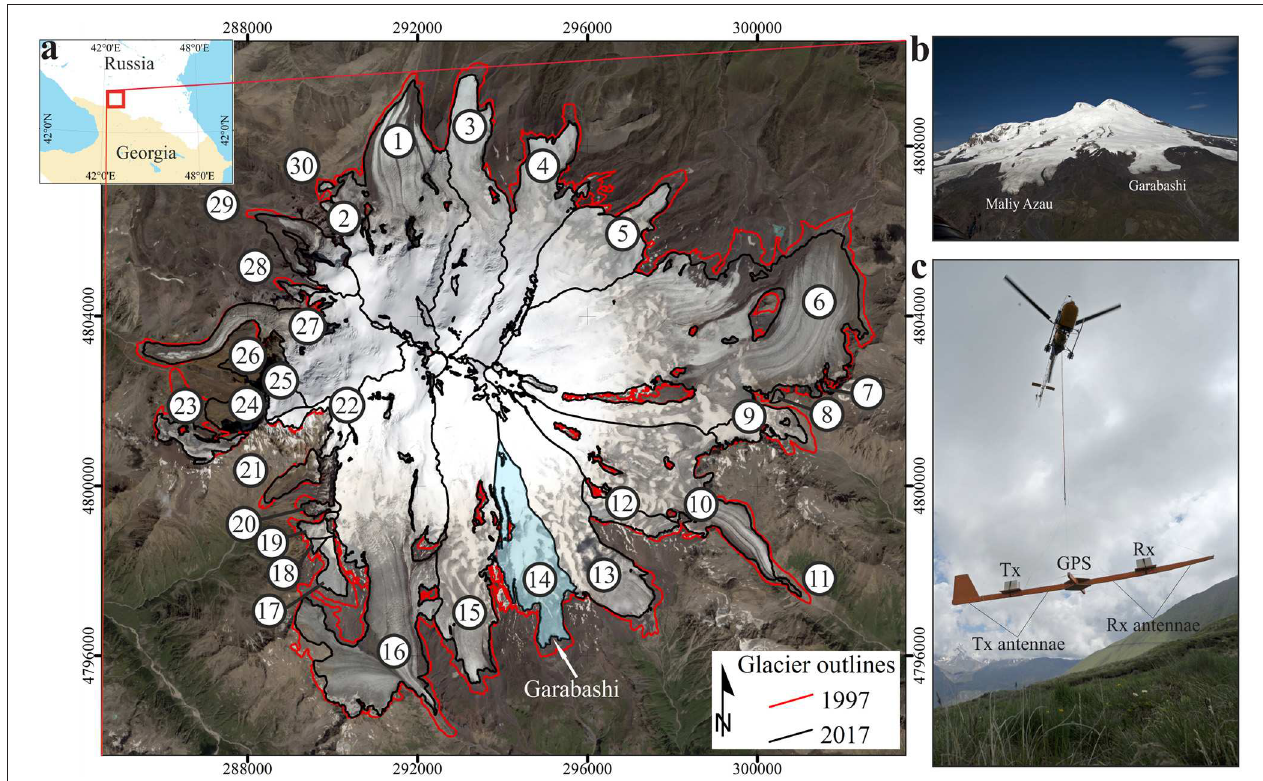
FIGURE 1 | (a) Location of Mt. Elbrus. Changes in glacier area between 1997 (red) and 2017 (black) are superimposed on a SPOT 7 image obtained on 20 August 2016. Numbers mark individual glaciers; see Table 2 for their names and statistics. Rectangular coordinates are recalculated for UTM Zone 38 projection. Oblique photographs of glaciers on Mt. Elbrus (b) and of a helicopter with suspended GPR VIRL-6 on a wooden frame (c)